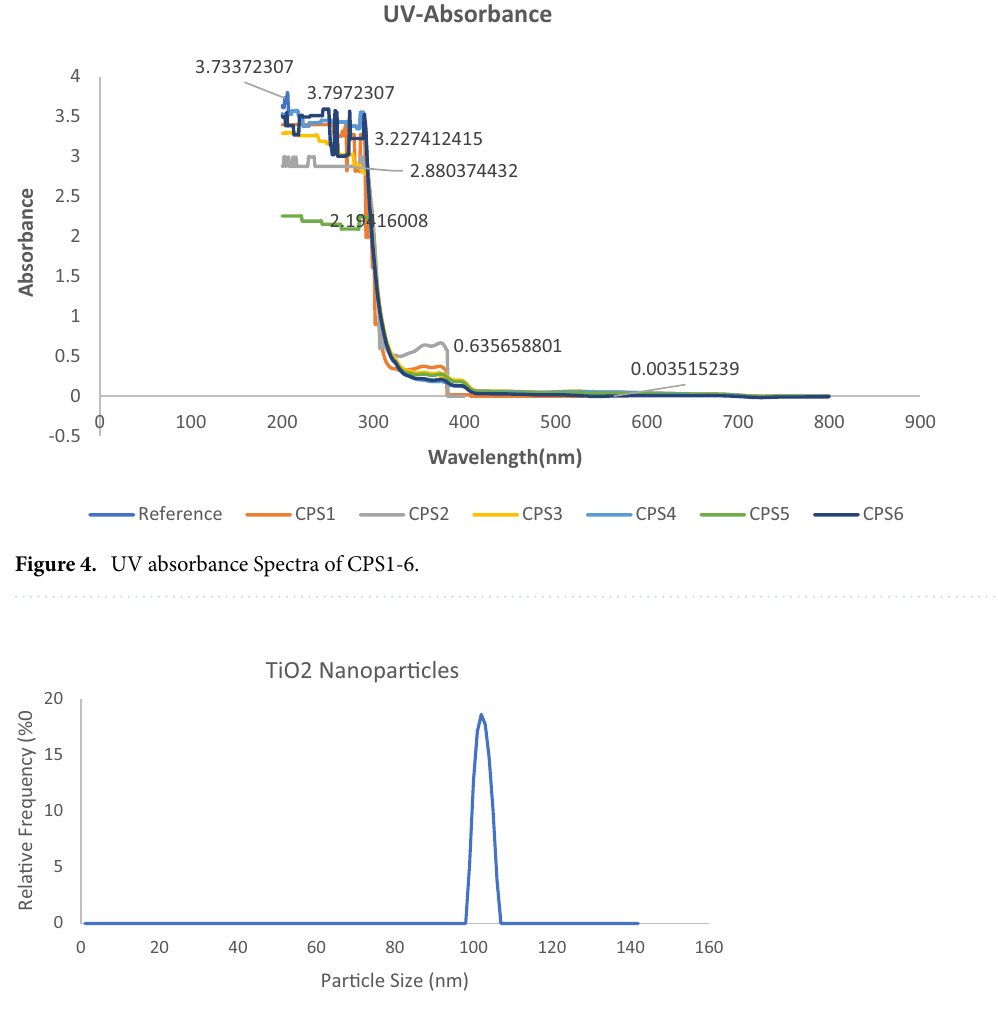
Figure 5. Particle size of TiO 2